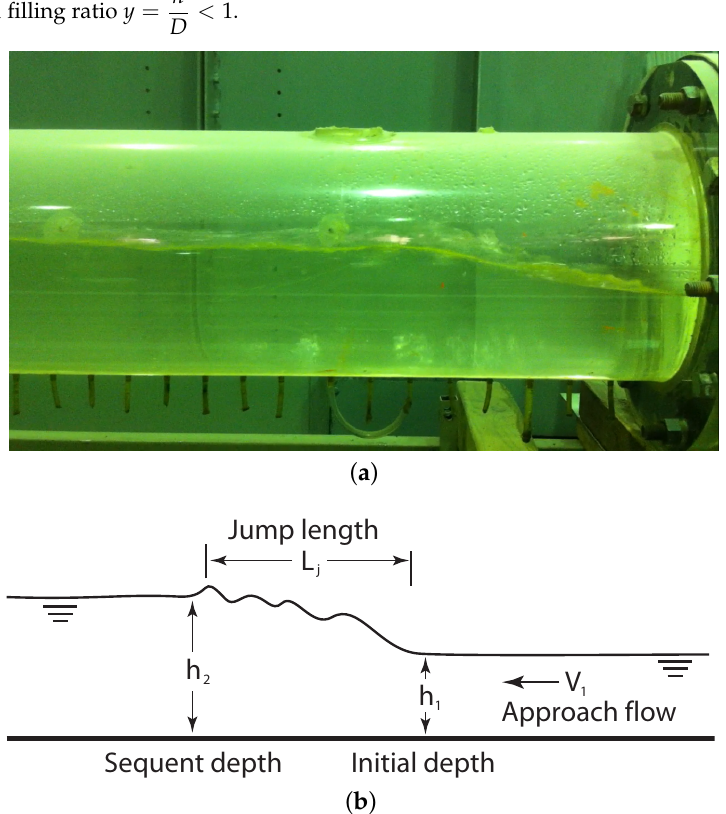
Figure 2. The hydraulic jump: ( a ) Photo of a hydraulic jump in a horizontal circular pipe from flow experiments conducted in the Hydraulics Laboratory at Concordia University. The flow was driven by head water at upstream, the effect being equivalent to that of gravity on flow in a sloping pipe. The jump was produced by a control acting further downstream. ( b ) Definition diagram of the hydraulic